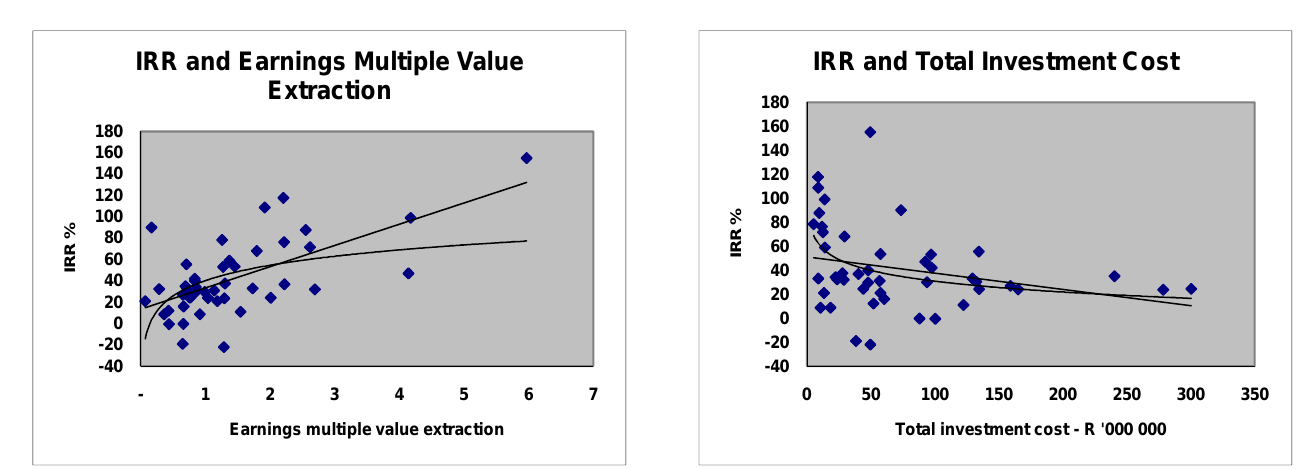
Figure 5: IRR and earnings multiple value extraction scatter plot Interest rates